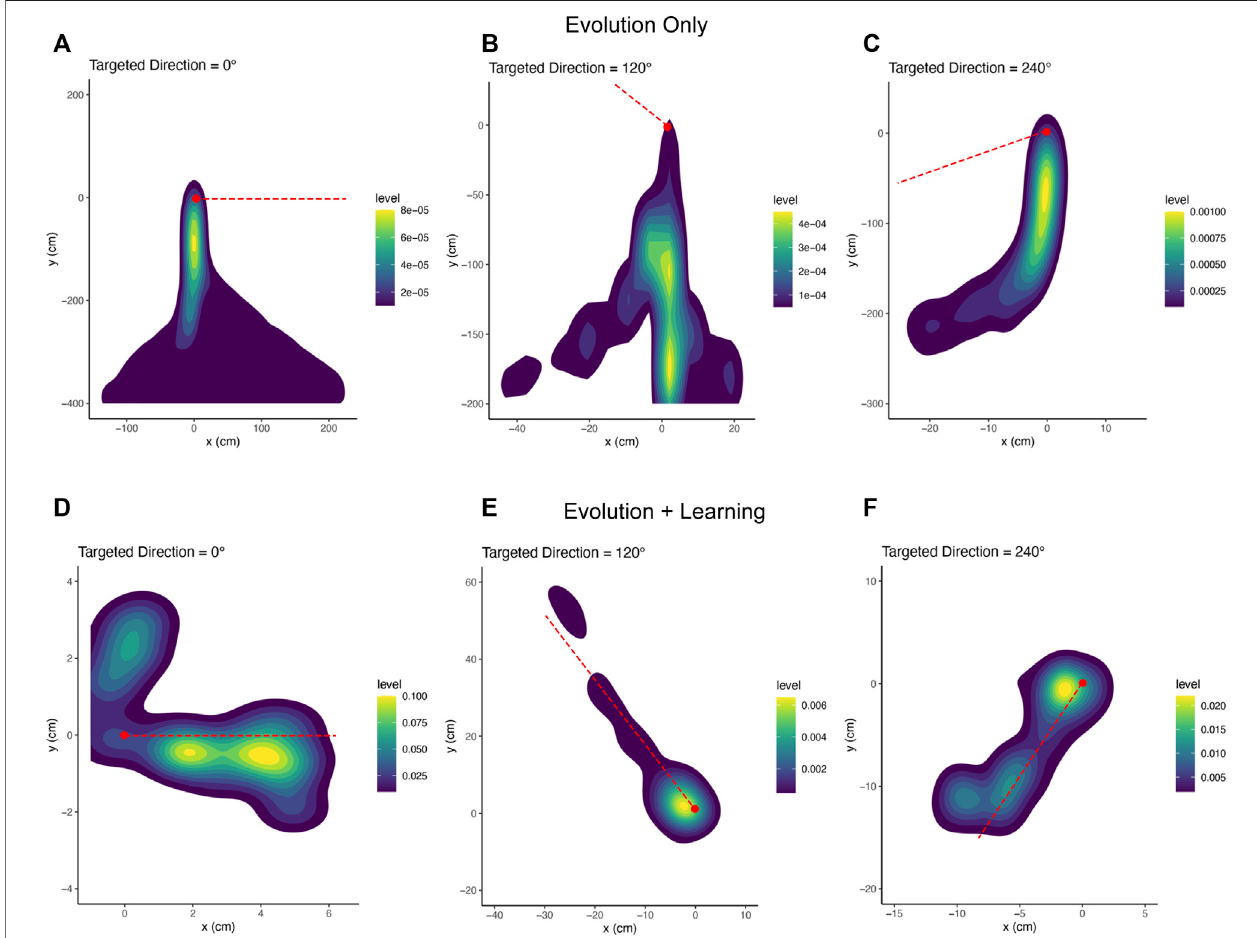
FIGURE 16 | Trajectory density plots of the robots with maximum fi tnessin the last generation of all runs. The red dashed lines are the targeted directions. The red dots are the starting points.